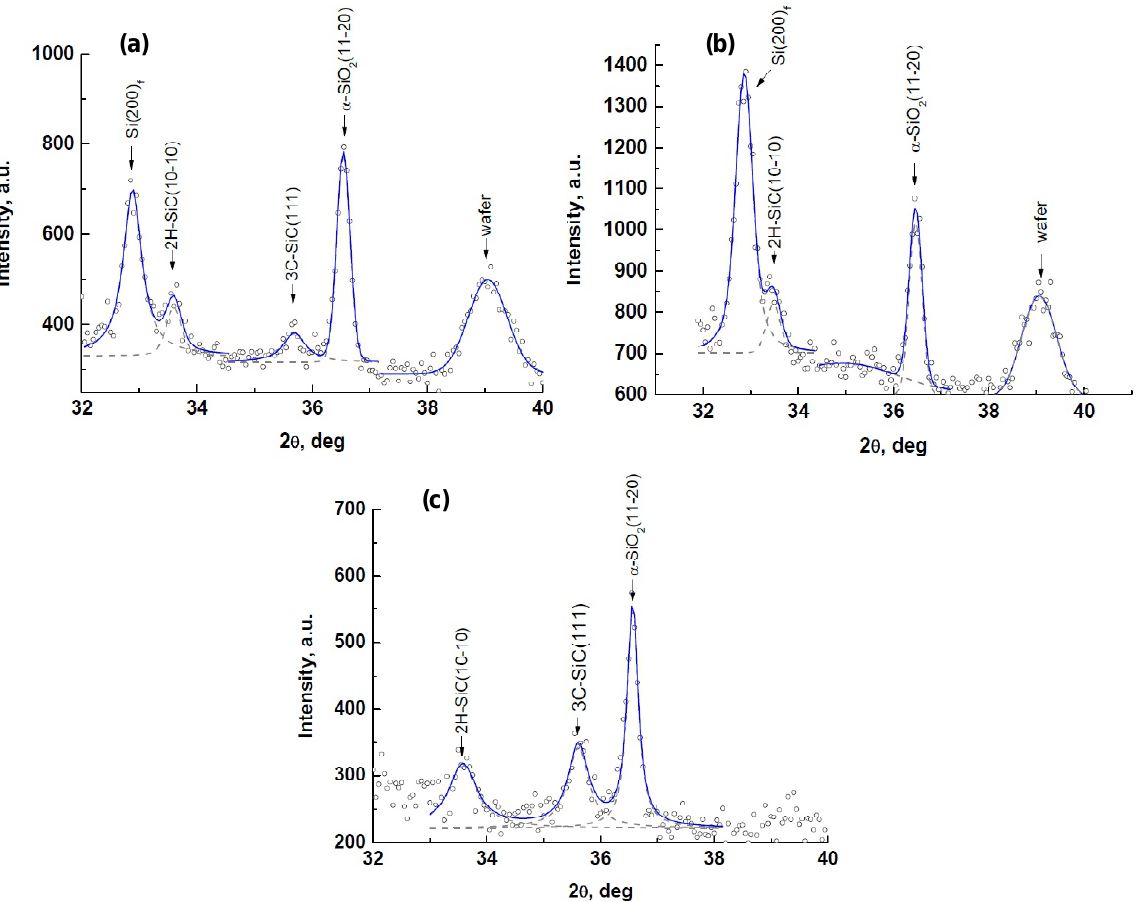
Fig. 5. X-ray difractograms of SiC samples, grown on Si(100)/Al SiC/Si(100) on sapphire Fab-2-R-plane; (b)” SiC/Si(100) on sapphire Fab-1-R-plane; (c) SiC/Si(111) on sapphire